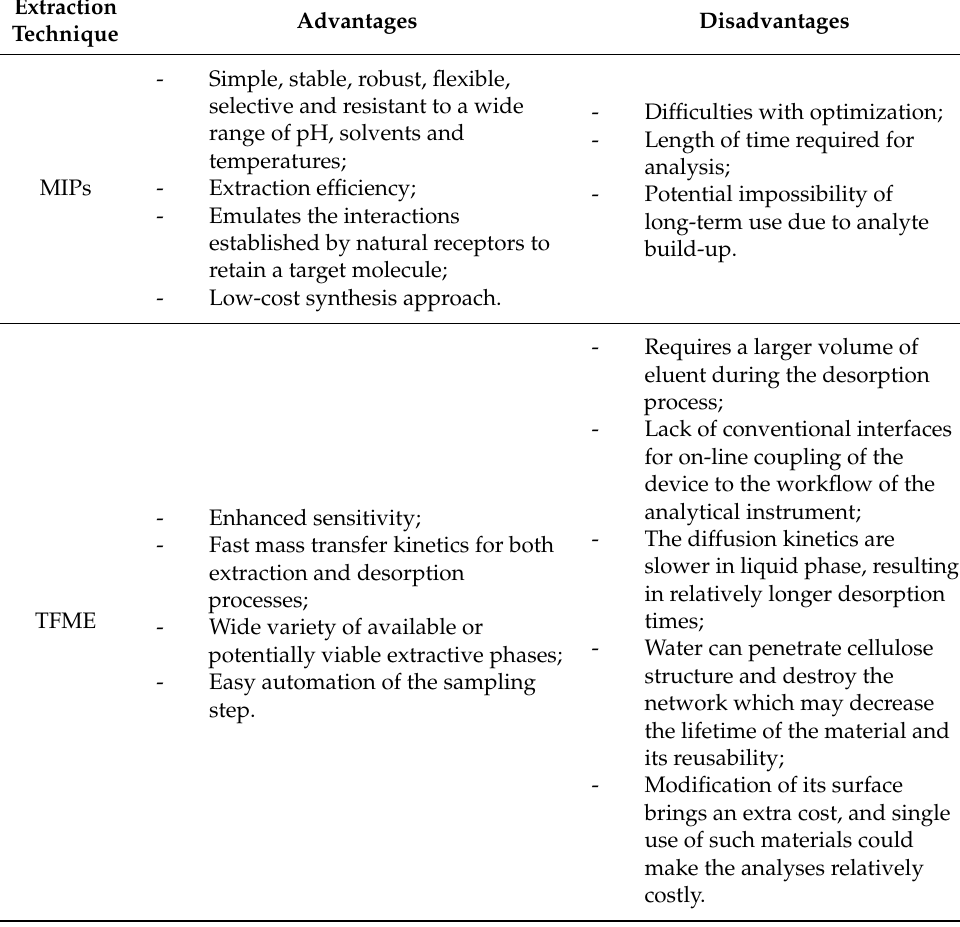
Table 10 contains the bioanalytical procedures published between 2021 and 2022 (MIPs) and published between 2010 and 2022 (TFME) concerning